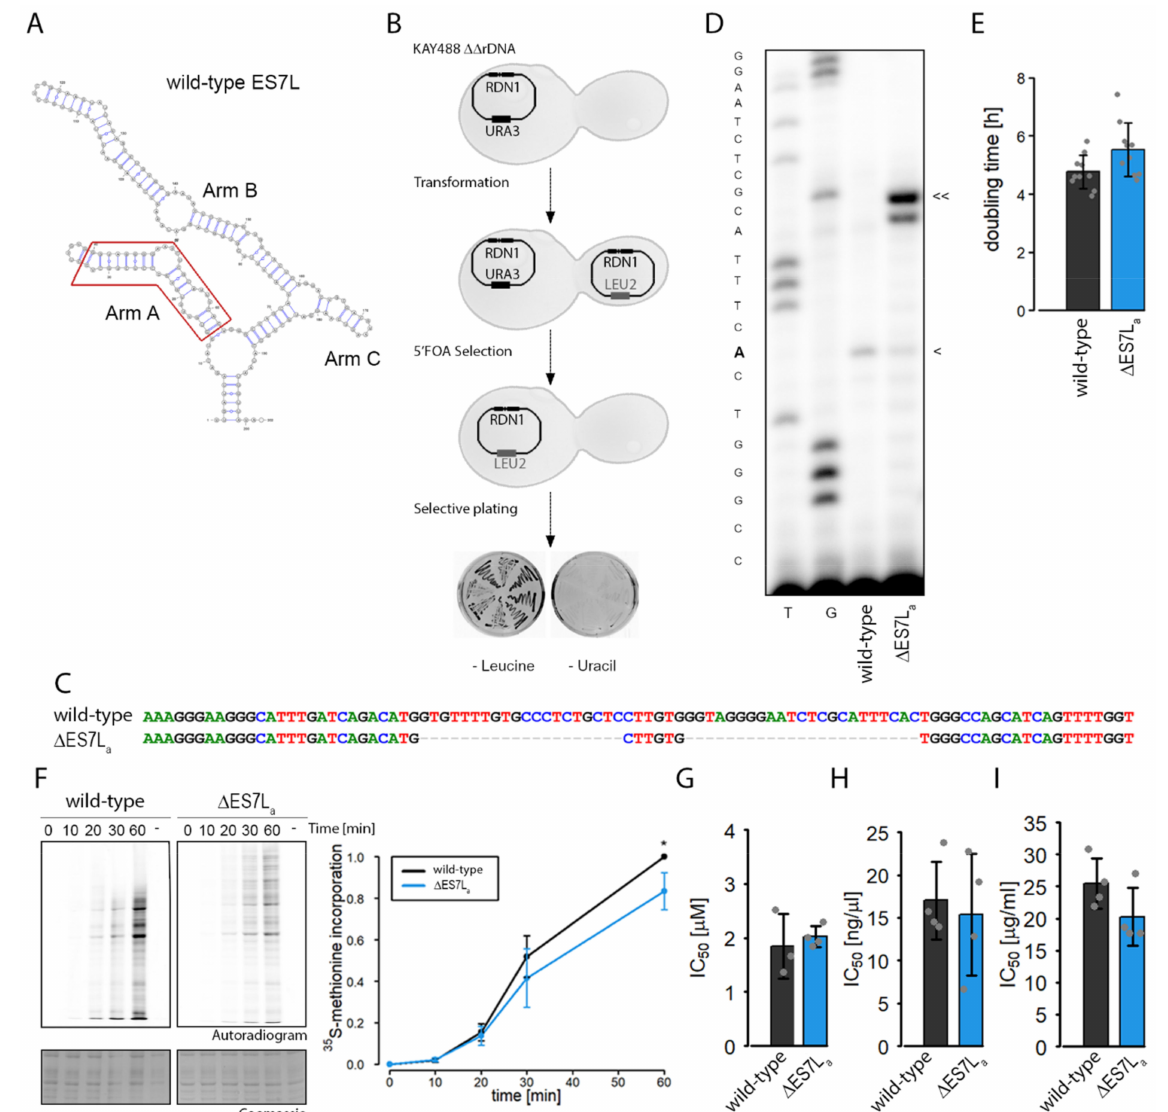
Figure 1. Effects of ES7L A-arm deletion on growth rate and translation. ( A ) Predicted secondary structure of ES7L. The secondary structure model was predicted using mFold [31]. Arms are indicated, and the deleted region is highlighted in a red frame. ( B ) Schematic presentation of the plasmid exchange strategy. The rDNA deletion strain KAY488 was transformed with pNOY373 encoding mutant rRNA. Strains were selected on selective plates and positive clones grew on—Leucine but not on—Uracil plates. ( C ) Plasmids were re-isolated from the positive strains and sequenced. Lines indicate gaps in the alignment which are in line with the deletion strategy. ( D ) Poisoned primer extension was performed to ensure that the strains only express mutant rRNA. The primer extension reaction stopped at the first A encountered (marked with < for wild-type and << for the deletion strain) because of addition of ddTTP to the reaction mixture. Total RNA isolated from the deletion strains served as template for primer extension. As controls, two sequencing reactions (T, G) and a primer extension with wild-type RNA were performed. ( E ) Doubling time of each strain obtained with plate reader experiments in YPD medium. ( F ) Metabolic labelling experiment was performed with cells from all four strains. Numbers depict time points after which samples were isolated. “-“ indicates a cycloheximide control. Quantified metabolic labelling results of wild-type and ∆ ES7L a . The 35 S-methionine signal in the autoradiogram was normalized to the signal of the Coomassie staining and finally to wild-type at timepoint 60 min (3 biological replicates). Significant 20% reduction of translation was observed after 60 min (Significant differences were determined using the two-tailed unpaired Student’s t -test (* p < 0.05). ( G – I ) Sensitivity to antibiotics: IC 50 calculated from growth rates in different antibiotic concentrations (G: Anisomycin, H Cycloheximide, I: Blasticidin S). All data is indicated as mean ± standard